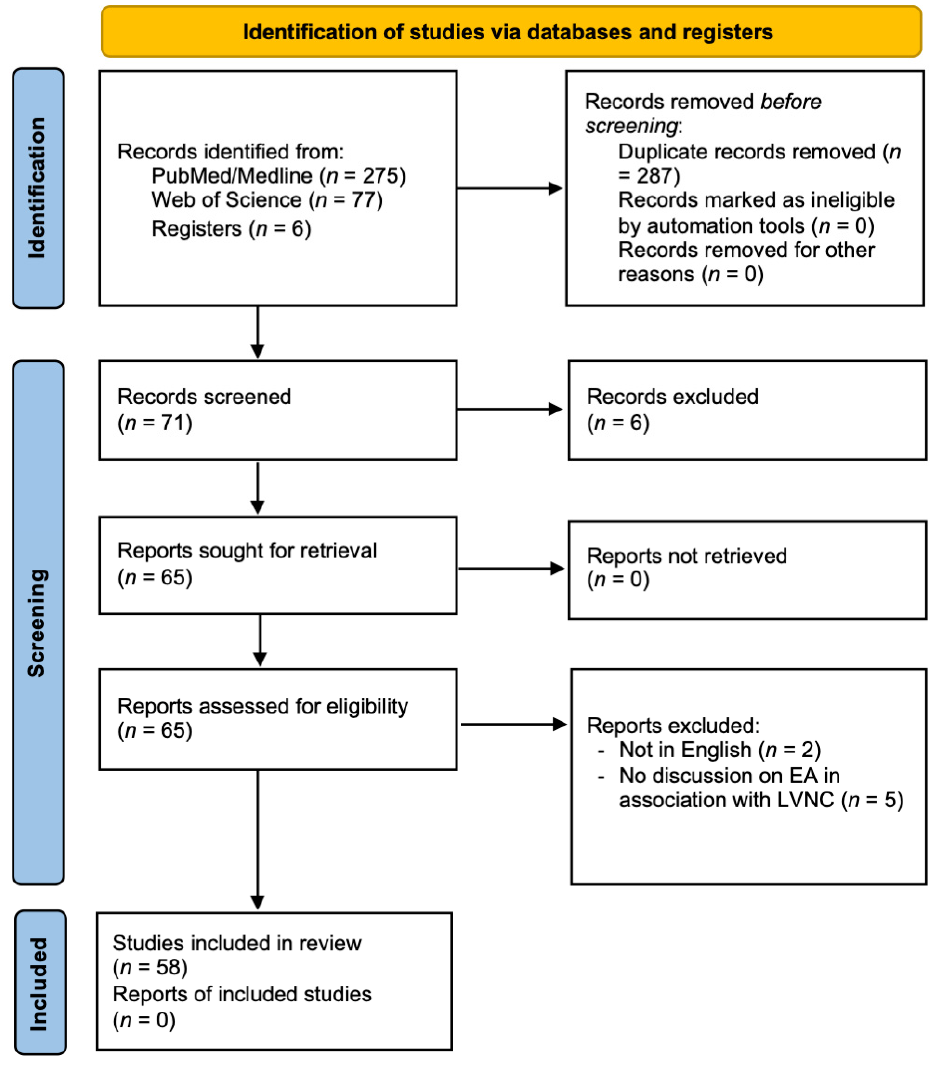
Figure 2. PRISMA 2020 flow diagram [23,24] for this systematic review on EA/LVNC.